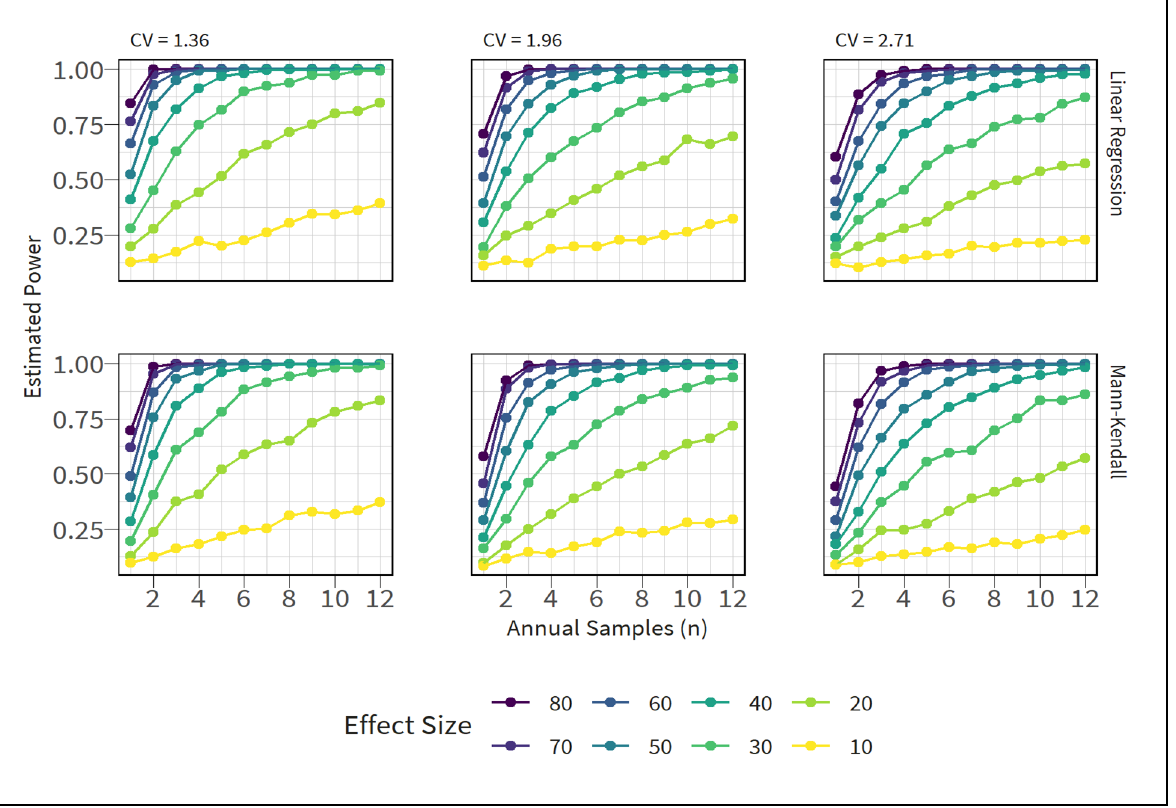
Figure 5. Estimated statistical power of Mann-Kendall and linear regression trend tests at upper, middle, and lower quartiles of observed station E. coli